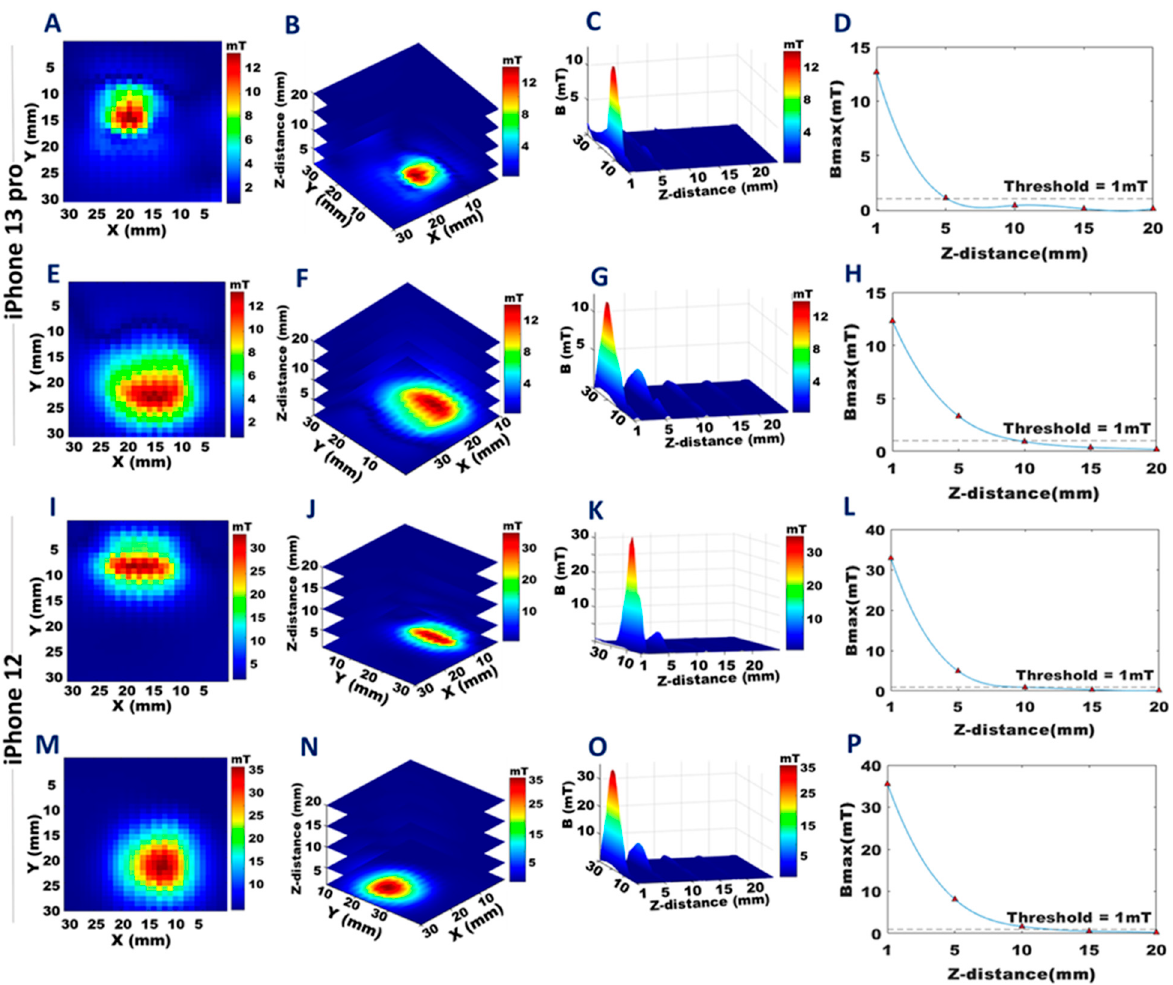
Figure 6. Distribution of the stray magnetic fields induced by the top and bottom stereo speakers of the iPhone 13 Pro and the iPhone 12. The colors represent the strength of the magnetic fields and are scaled to the maximum B-field of each data set. A , E , I , and M : The 2D distribution of the stray magnetic field of the stereo speakers for a transversal plane placed at a z-distance of 1 mm from the top speaker ( A ), ( I ), and the bottom ( E ), ( M ) speaker of the iPhone 13 Pro and the iPhone 12. B , F , J , and N : The 3D distribution of the stray magnetic field of the stereo speakers for transversal planes placed at z = 1, 5, 10, 15, and 20 mm from the top ( B ), ( J ) speaker and from the bottom ( F ), ( N ) speaker of the iPhone 13 Pro and the iPhone 12. C , G , K , and O : The 3D stray magnetic field variation with increasing distance from the top ( C ), ( K ) speaker and from the bottom ( G ), ( O ) speaker of the iPhone 13 Pro and iPhone 12. D , H , L , and P : Maximum stray magnetic field (B max ) versus the z-distance from the top speaker ( D , L ) and the bottom speaker ( H , P ) of the iPhone 13 Pro and the iPhone 12. A closer examination of the MagSafe charger (Movie S4) alone showed B max = 108.4 mT at 1 mm (Figure 7A), decreasing to B ≤ 1 mT at 25 mm (Figure 7B–D). When the iPhone 13 Pro was placed on the MagSafe charger, the stray magnetic field obtained was B max = 7.2 mT at 1 mm distance from the back surface of the MagSafe charger (Figure 7E), decreasing to B ≤ 1 mT at 20 mm (Figure 7F–H). When the iPhone 12 was placed on the MagSafe charger, B max = 7.2 mT at 1mm from MagSafe charger back surface (Figure 7I), decreasing to B ≤ 1 mT at 20 mm (Figure